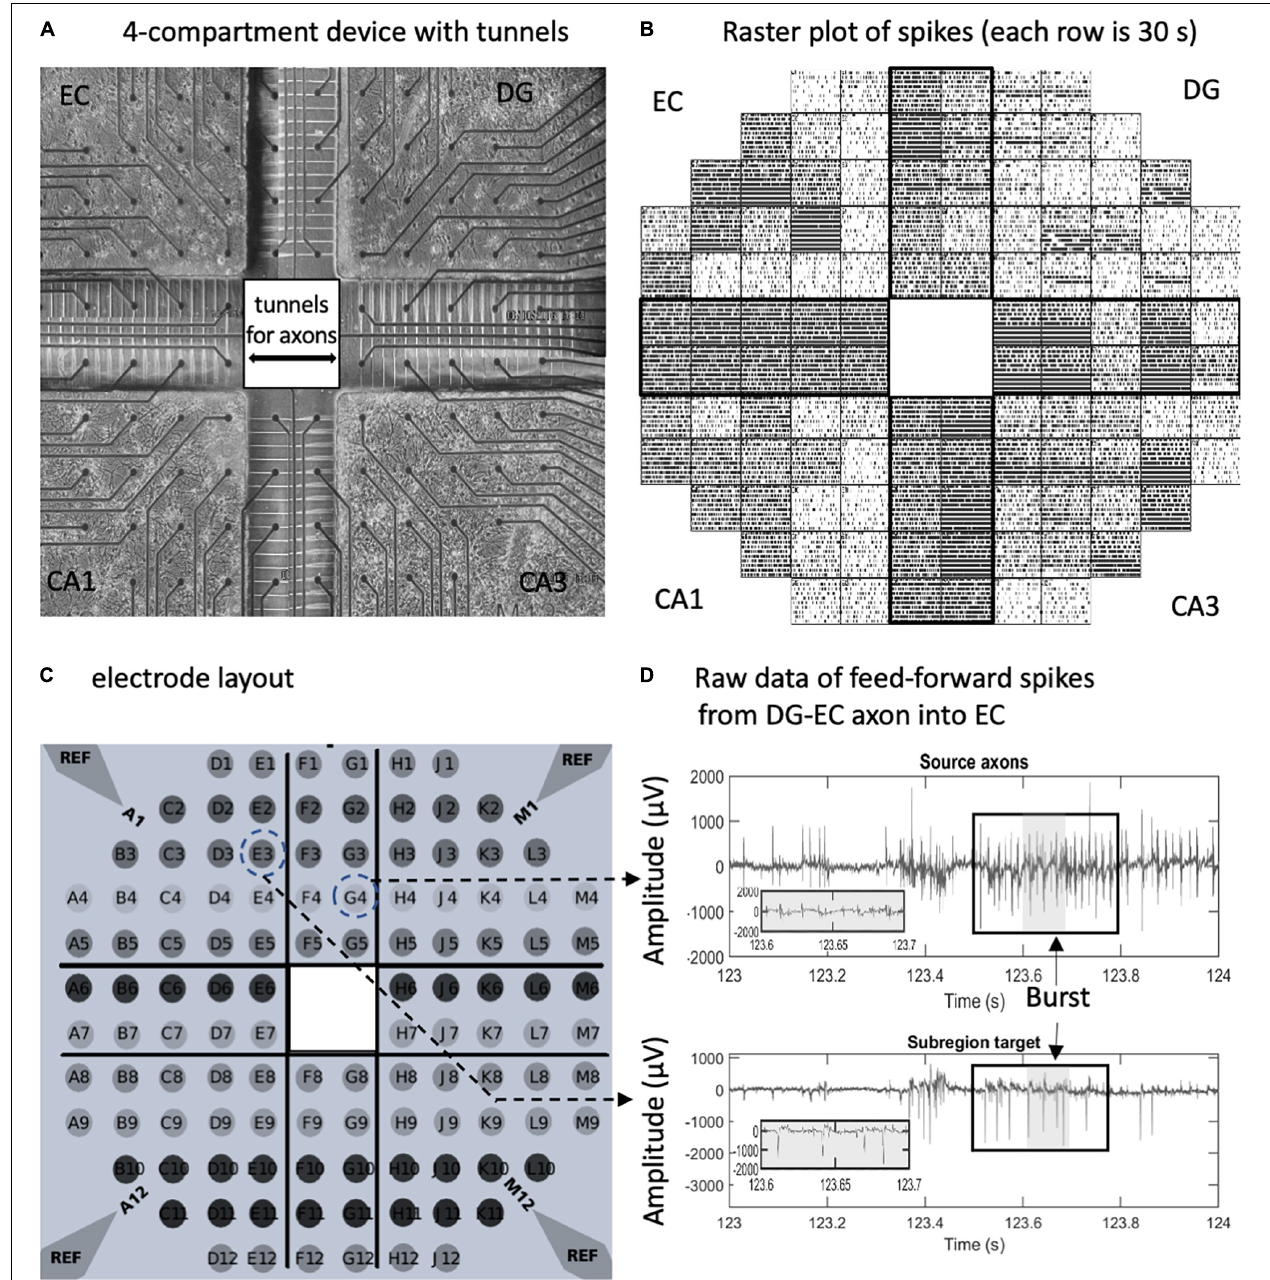
FIGURE 1 | In vitro neuron culture of four separate hippocampal subregions with axonal interconnections aligned on a 120-electrode array. (A) Phase contrast image after 3 weeks in culture. Spacing between the 30- µ m diameter electrodes is 0.2 mm. (B) Raster plot of spikes detected on individual electrodes over 5 min (30 s/row). Each tick is one spike. (C) Electrode array layout. Reference ground electrodes are seen in the corners. (D) Electrical feedback signals from the indicated electrodes with source axons in the dentate gyrus (DG)- entorhinal cortex (EC) tunnel appearing to elicit a response in the EC target. Large spike signal to noise ratios without high-pass filter. Box indicates a burst in spikes. Gray area is enlarged.